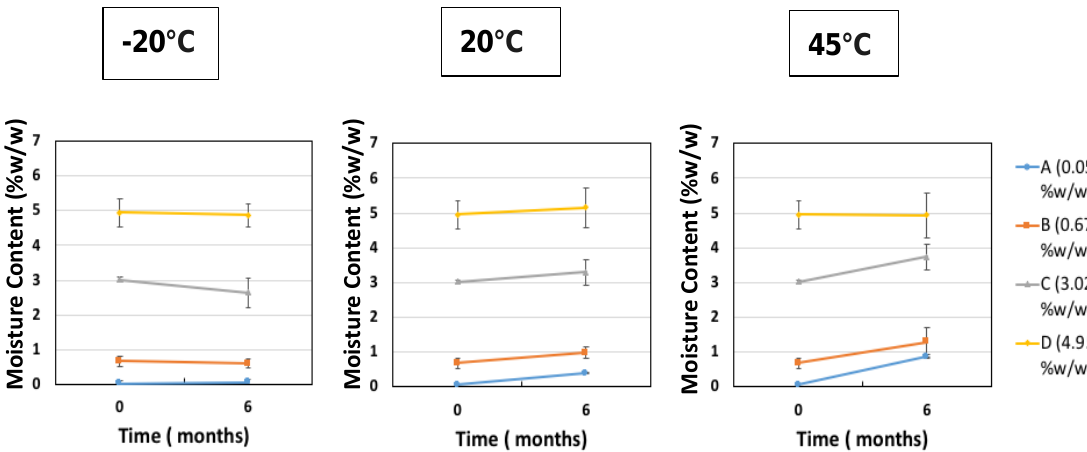
Figure 5. Change in moisture content (% w/w) after 6 months of storage starting at different initial starting moisture samples of IgG 50 mg/mL (A = 0.05% ± 0.01% w/w, B = 0.67% ± 0.14% w/w, C = 3.02% ± 0.06% w/w and D = 4.95% ± 0.40% w/w) at − 20 °C, 20 °C and 45 °C. Error bars represent 95% confidence intervals ( n = 3 vial replicates).